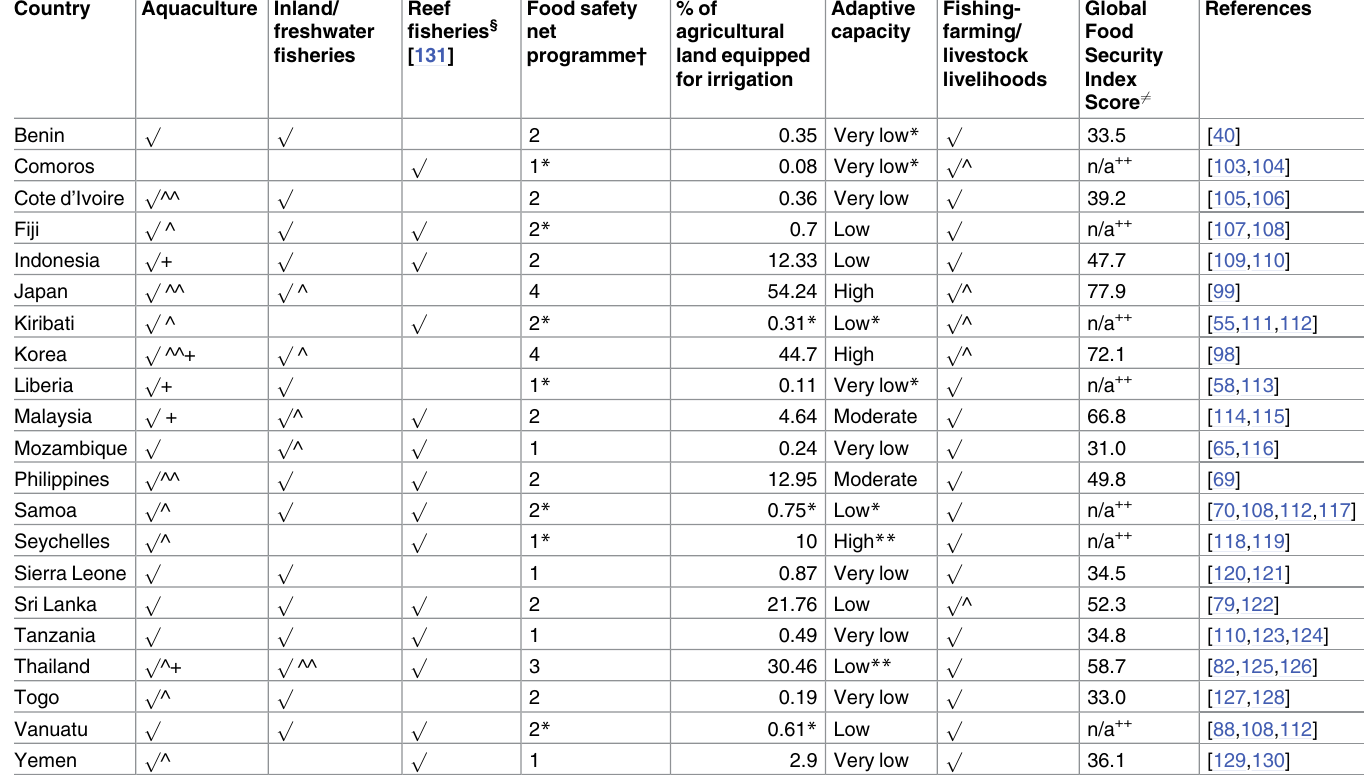
Table 5. Presenceof factors that may potentially dampen the effect of decreasedfish supply due to high seas closure in countries projected to experiencenet catch losses. Country Aquaculture Inland/